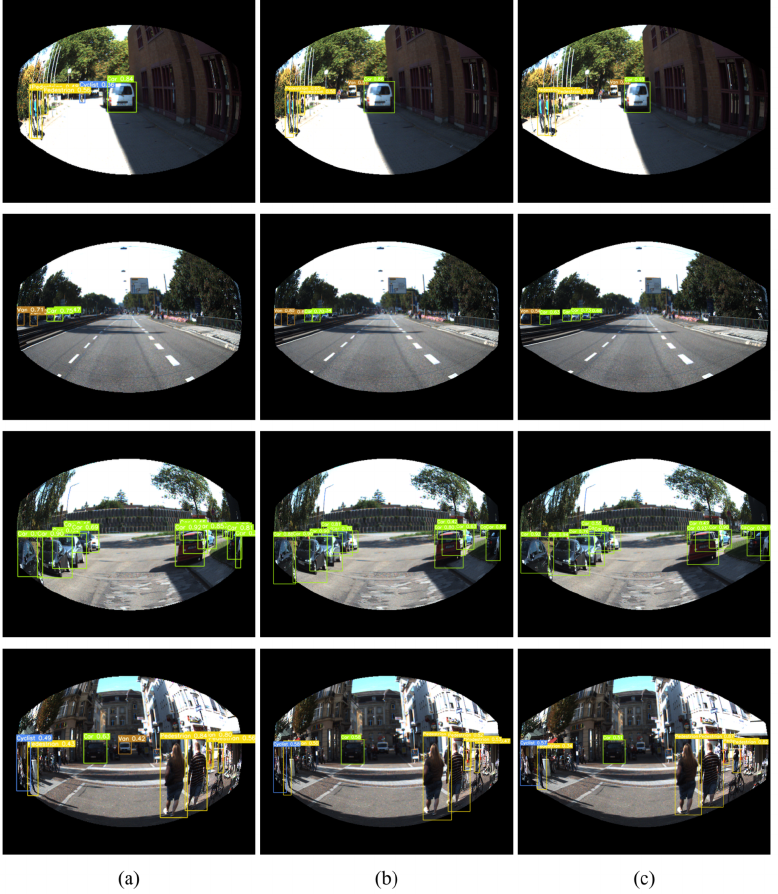
Figure 11. Detection result from ( a ) Synthetic fisheye image, ( b ) Spherical-Projected image, and ( c ) Expandable-Spherical-Projected image.